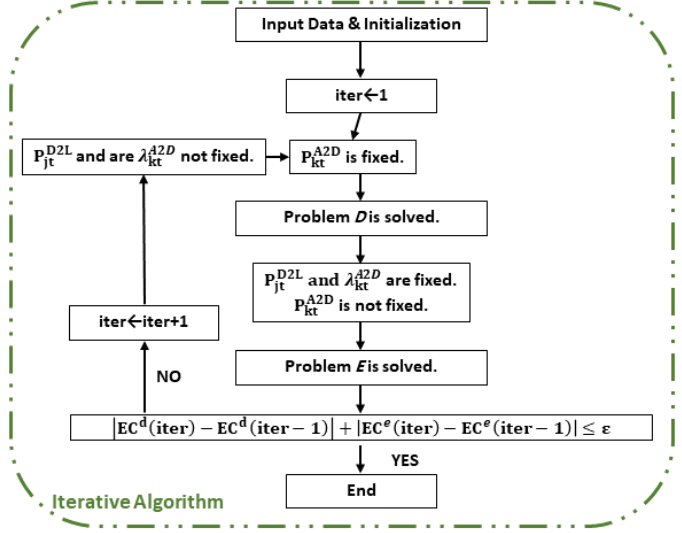
Figure 5. Proposed iterative algorithm for energy trade between end-users and the Distribution Company